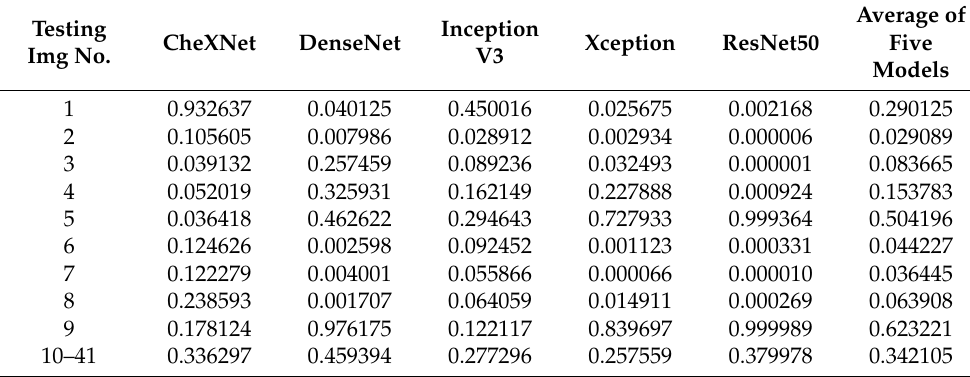
Table 3. Average testing probabilities of five models on RCFV dataset